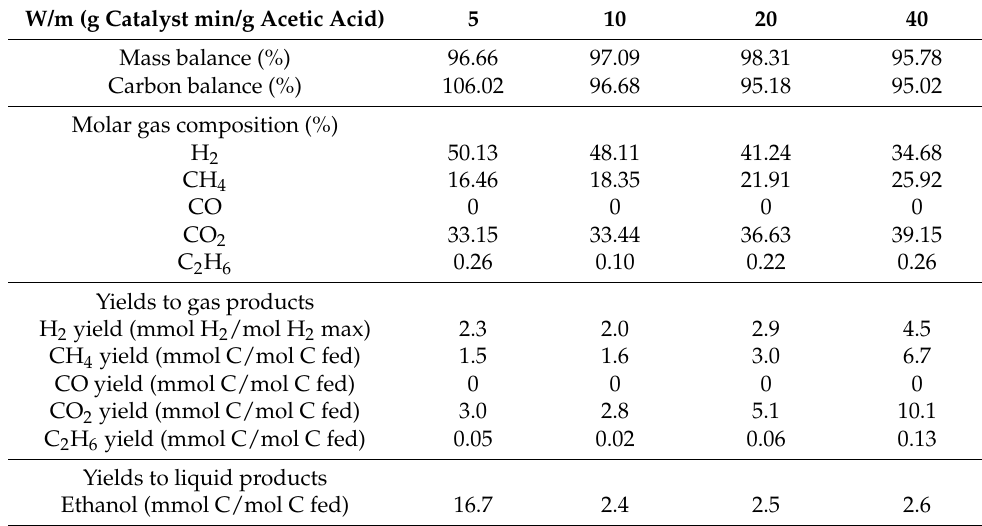
Figure 3. Carbon yield to gases and liquids in the APR of acetic acid at different catalyst loading (T = 227 ◦ C, 40 bar, 5 wt% acetic acid, Ni-Co/Al-Mg catalyst, 1 mL/min aqueous feeding rate). Table 4. Results of the APR experiments of acetic acid (T = 227 °C, 40 bar, 5 wt% acetic acid, Ni-Co/Al-Mg catalyst, 1 mL/min aqueous feeding rate).